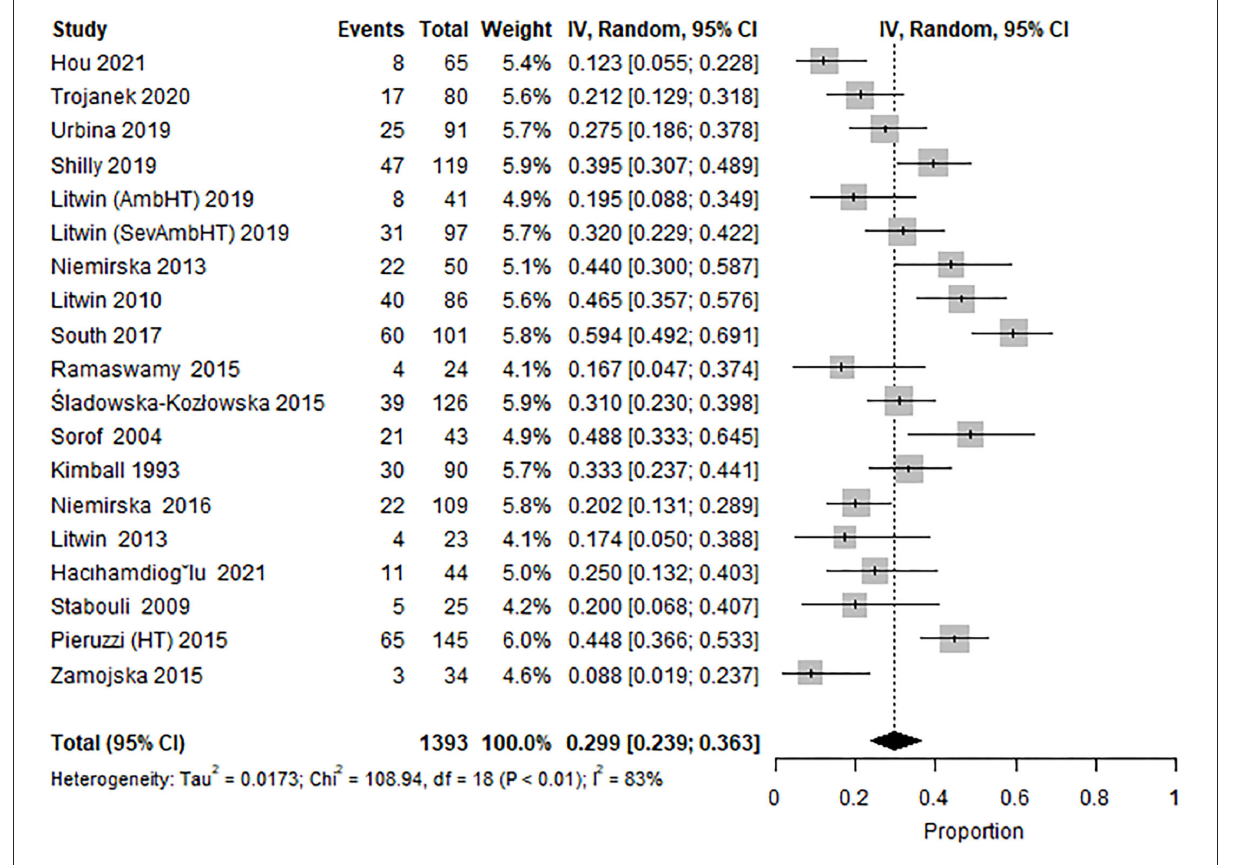
FIGURE3 Forest plot showing the prevalence of LVH in the subset of studies from specialty clinics, LVH defined by ultrasound estimated LVMI ≥ 95th percentile and excluding subjects with WCH and/or preHT (18 studies, 19 study cohorts).